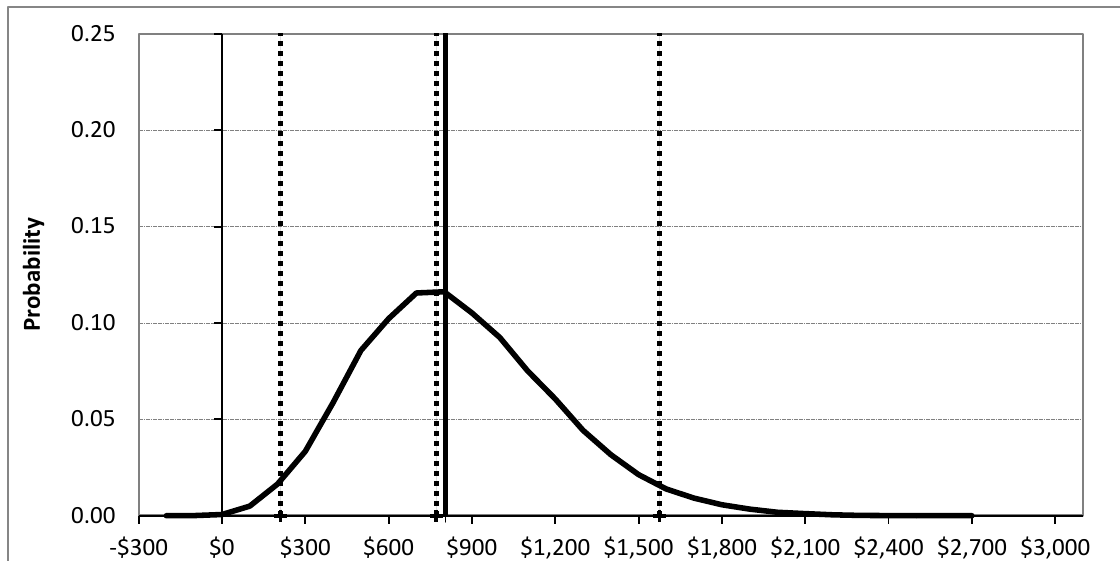
Figure 2. Net benefit estimation distribution.